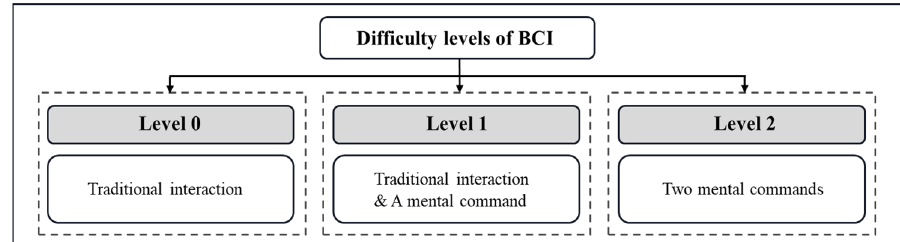
Figure 10. Difficulty levels of the operation interaction modes.